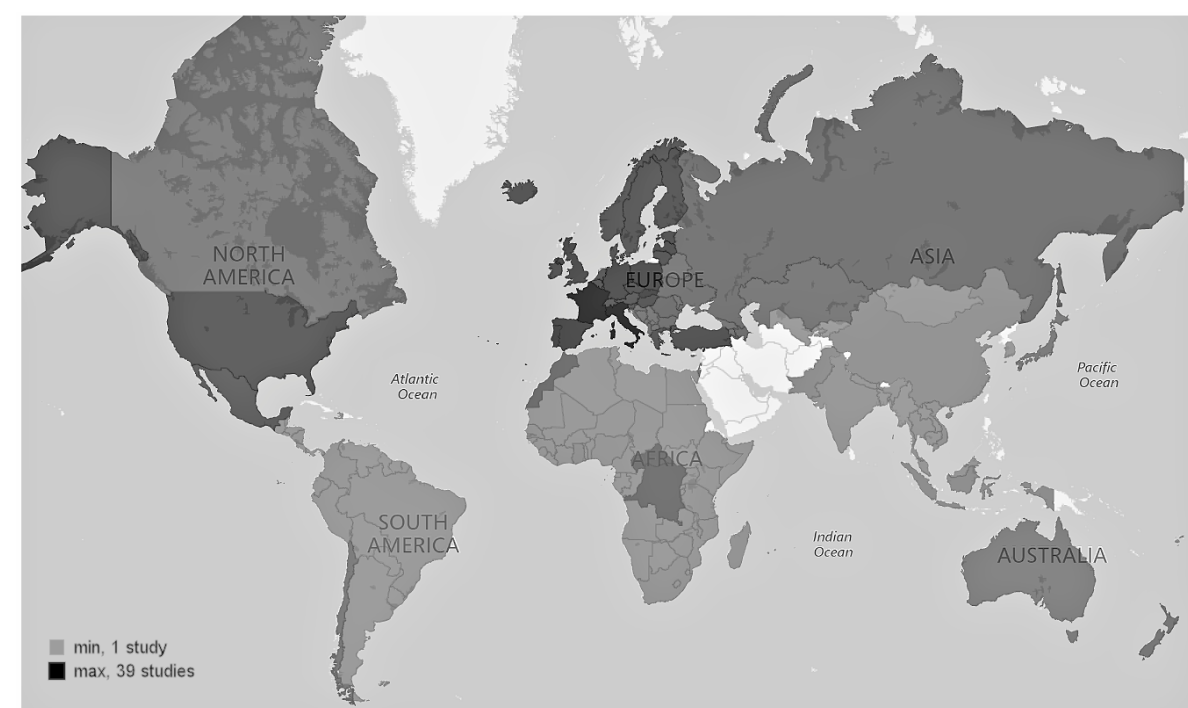
Figure 2. Geographical regions analysed for migration factors by frequency of dedicated